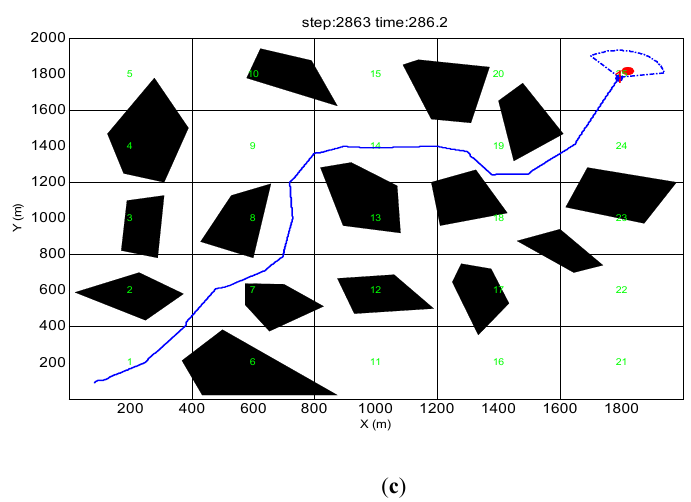
Figure 15 . Vortex obstacles environment obstacle avoidance trajectory. ( a ) PGOA (Predictive guidance obstacle avoidance). ( b ) APF (Artificial potential field). ( c ) PSO (Particle swarm optimization).